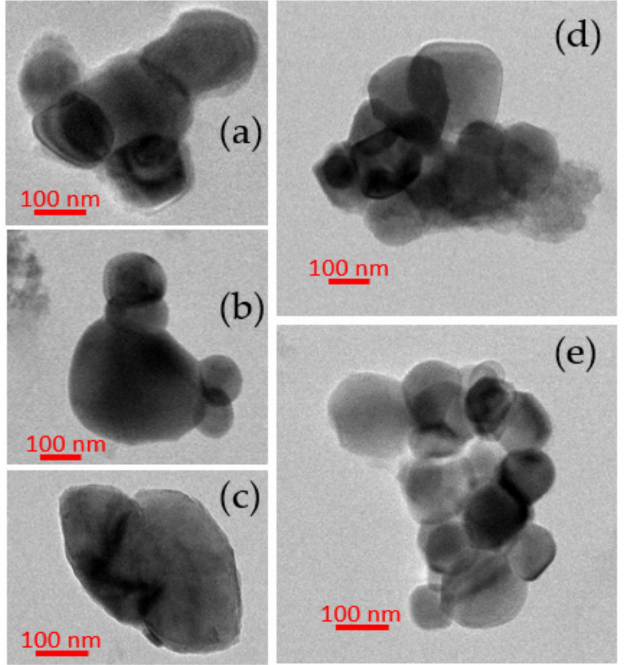
Figure 8. TEM images of particles detected in WWTP sludges: ( a ) Chihuahua South Summer; ( b ) Chi- huahua South Spring; ( c ) Casas Grandes Spring; ( d ) Chihuahua North Spring; and ( e ) Juarez